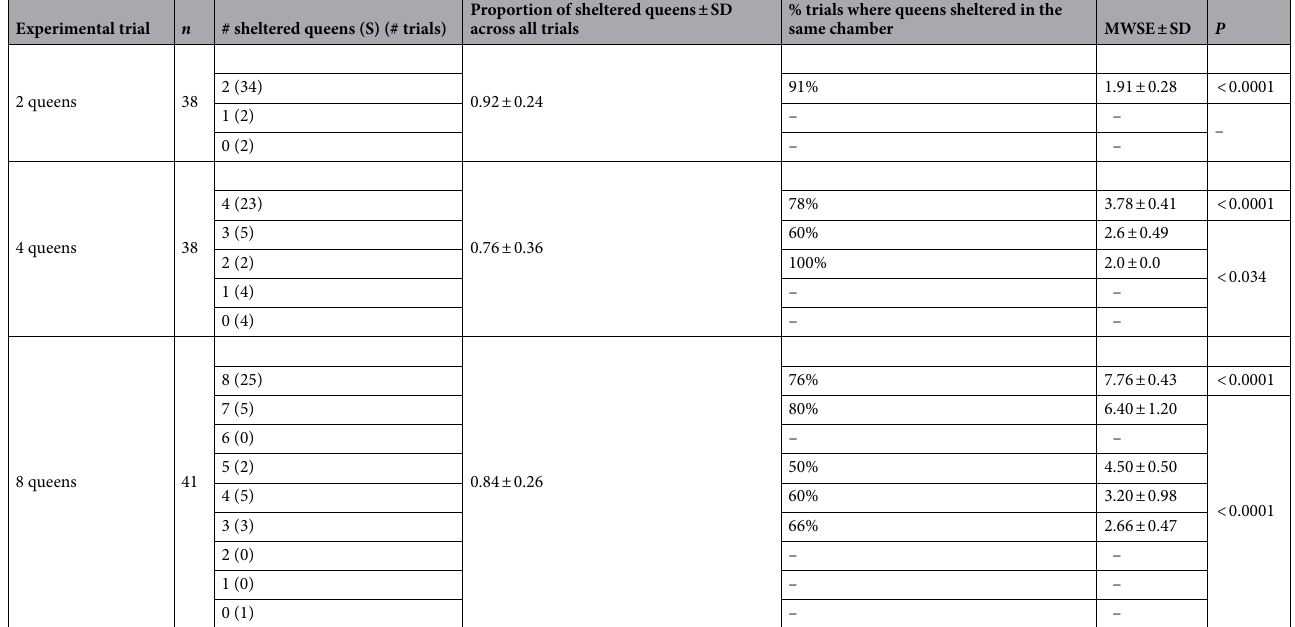
Table 1. Description of experiment and queen grouping patterns. The table indicates the results of the different types of experimental trials ( N = 2, 4, or 8 queens released in the arena at the start of the trial); the total number of trials of each type ( n ); the total number of sheltered queens ( S ) and the number of trials in which different values of S occurred (# trials); the mean proportion of sheltered queens ± SD across all the experimental trials of a certain type; the percentage of experimental trials in which sheltered queens were all in the same chamber; the mean number of sheltered queens in the largest group (MWSE) ± SD; and the probability of obtaining MWSE by chance, based on 10,000 simulations of random allocation outcomes . Experimental trials in which S = 0 or S = 1 were excluded when calculating MWSE and